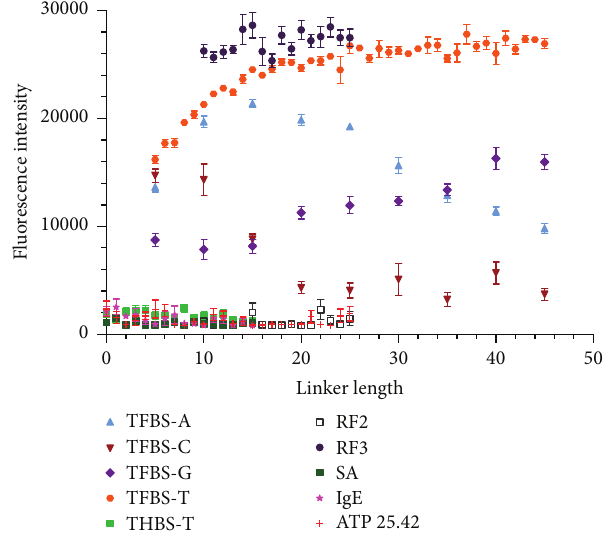
Figure 8: Binding of Cy3 dye in PBSMTB buffer to a variety of G- quartet and non-G-quartet aptamer sequences. Error bars represent SEM of raw fluorescence intensity values for 5–15 replicates of each sequence. Linker identity was T unless otherwise